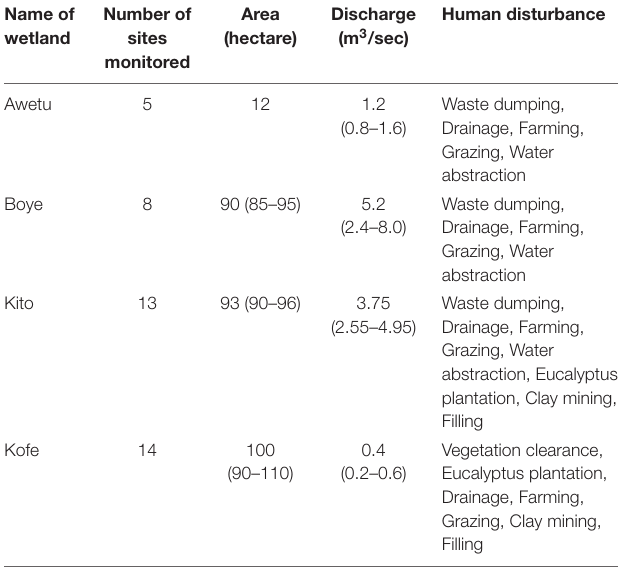
TABLE 1 | Characteristics of the study wetlands located in the Gilgel Gibe I watershed, southwest Ethiopia. Name of